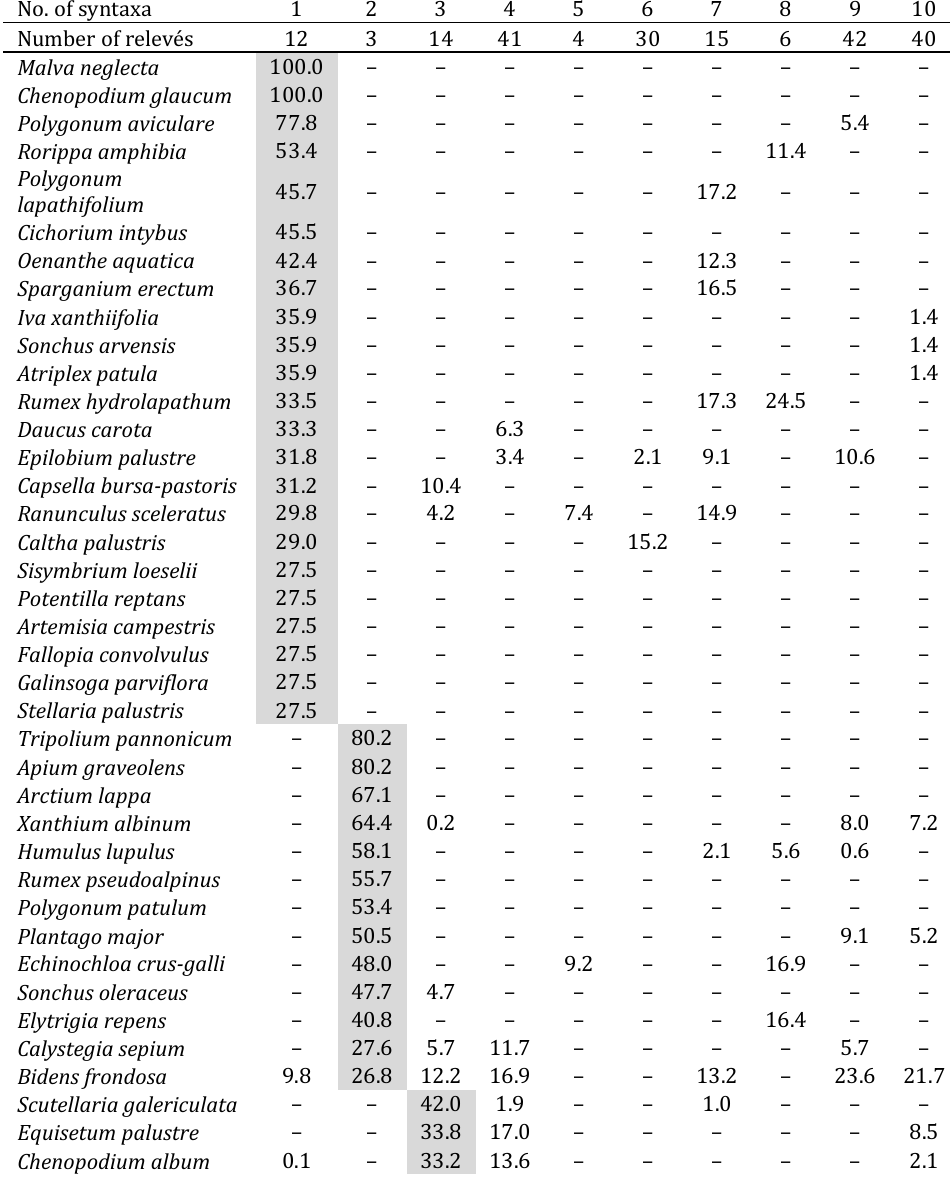
Fig. 12. Cluster analysis of the phytosociological data of the class Bidentetea . Clusters mark association: 1 – Chenopodietum rubri ; 2 – Xanthio riparii-Chenopodietum rubri ; 3 – Bidenti frondosae-Atriplicetum prostratae ; 4 – Junco bufonii-Bidentetum connatae ; 5 – Rumici maritimi-Ranunculetum scelerathi ; 6 – Polygonetum hydropiperis ; 7 – Bidentetum cernuae ; 8 – Bidentetum tripartitae ; 9 – Leersio-Bidentetum ; 10 – Myosotono aquatici-Bidentetum frondosae Table 3. Synoptic table of the class